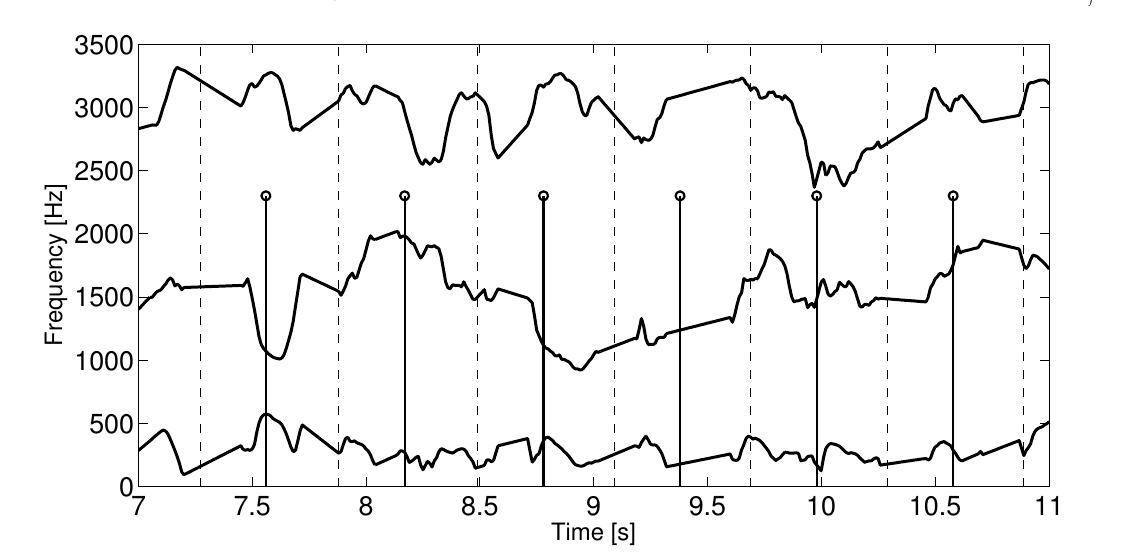
Figure 3. Example of the synchronization process with an approximately 10 heartbeat portion of a screen. The plot shows on a disproportional y-axis the three formant tracks. The heartbeats are indicated by the stem lines and the vertical dotted lines represent the interval on either side of the heartbeat marking the formant frames assigned to each